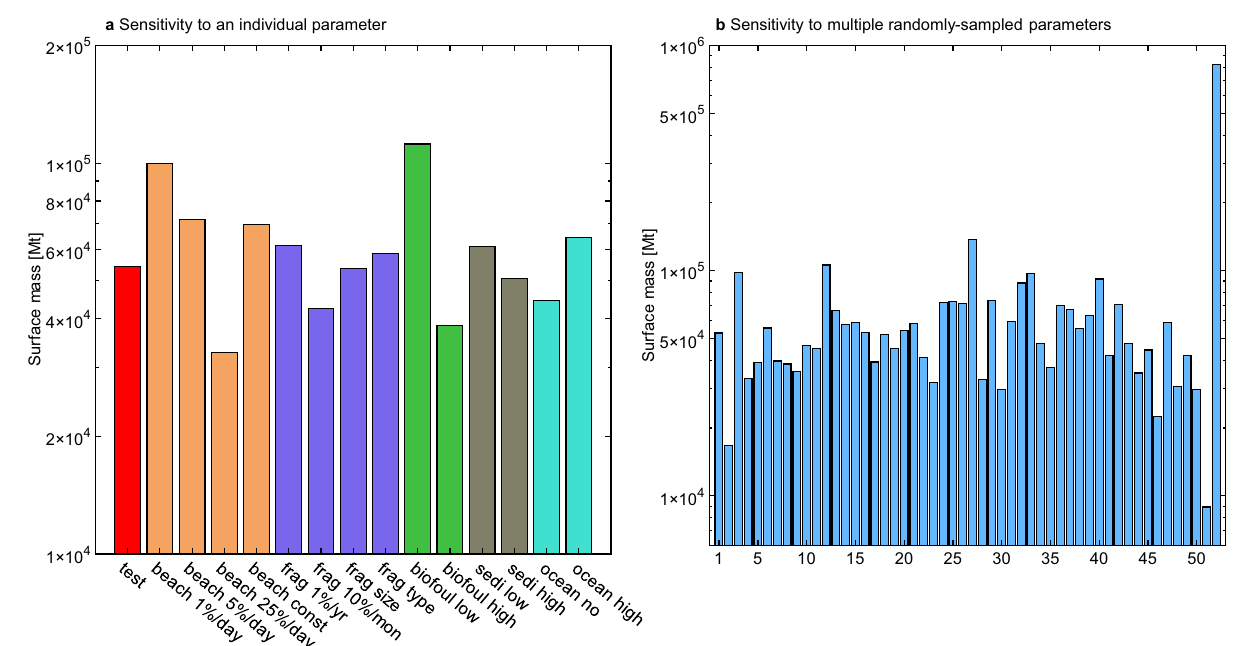
Fig. 3 | Sensitivity of the modeled total plastic mass in the surface ocean (Mt, metric tons) to different parameters. a Sensitivity to an individual parameter. b Sensitivity to multiple randomly-sampled parameters. Note the y -axis is on a logarithmic scale. The model scenarios include varying beaching, fragmentation,